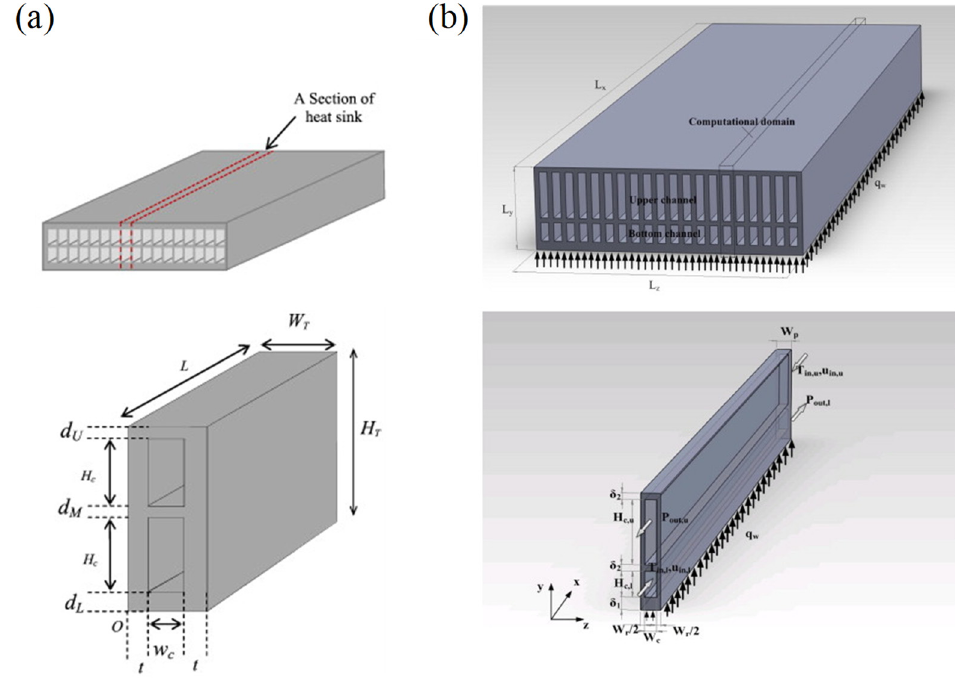
Figure 18. Geometry optimization of double-layer microchannels: ( a ) Hung et al. (adapted from Ref. [121]), ( b ) Hung et al. (adapted from Ref. [122]).